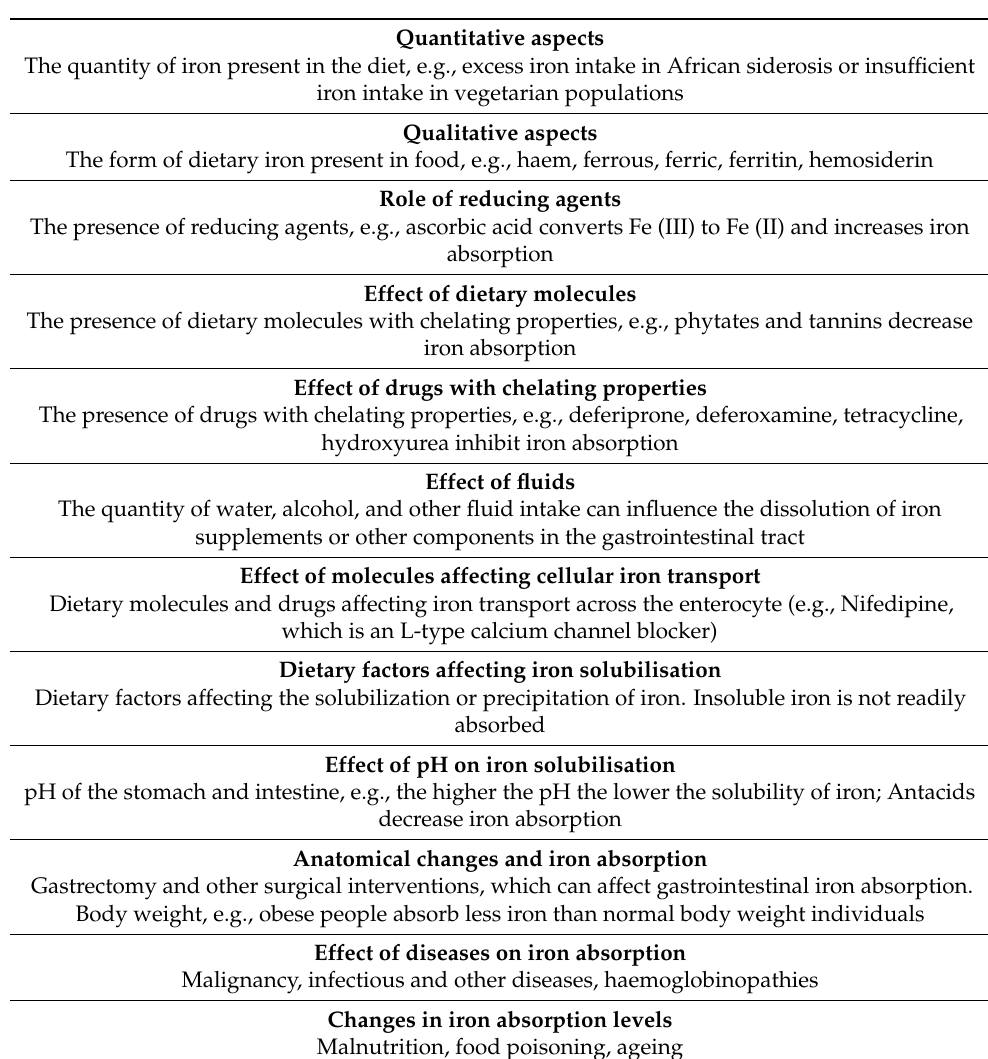
Table 1. Non-Regulatory Factors Affecting Iron